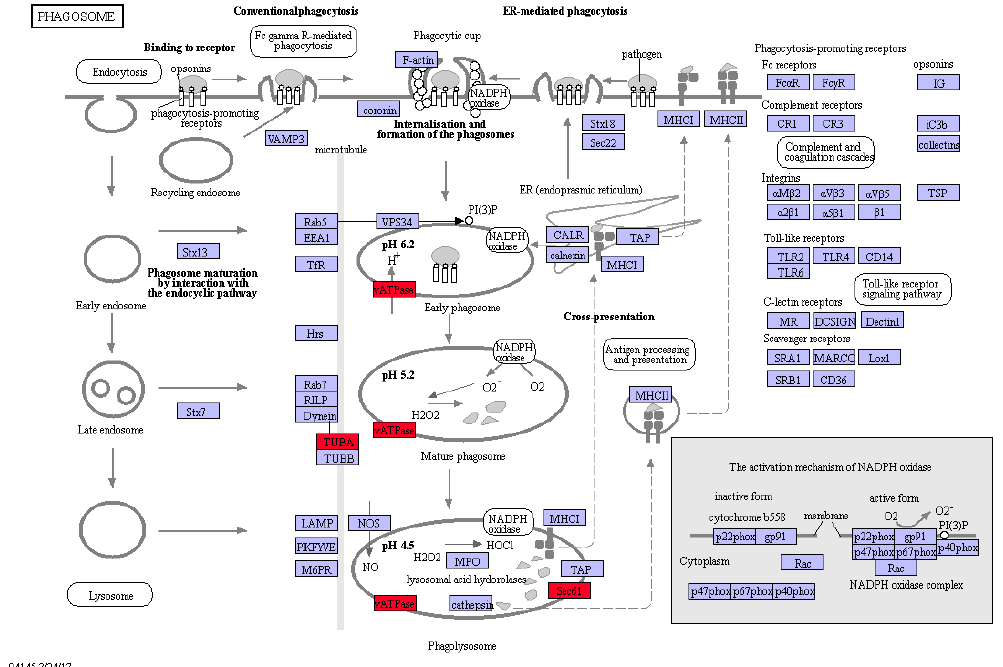
Figure 8. Changes of duckweed phagosome KEGG pathway between Pen3a and WT. The block’s color meant unigenes coding corresponding proteins, determined by the expression pattern. The red blocks indicated the up-regulated genes.